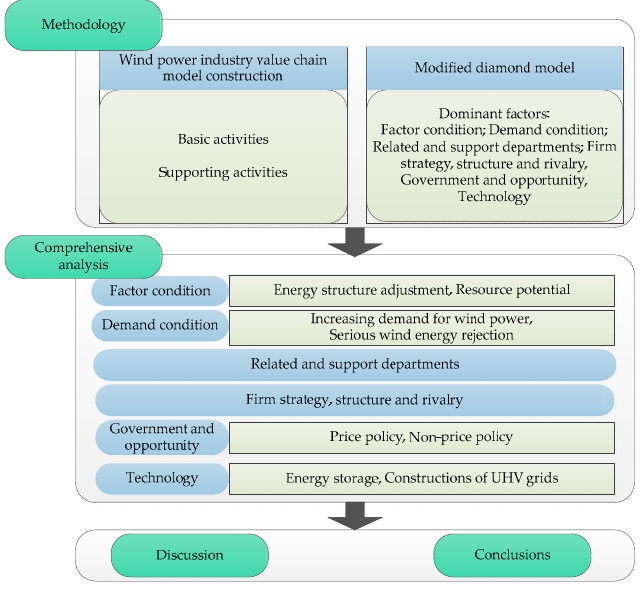
Figure 2. Schematic overview of the paper. Table 1. Main previous works focused on wind power industry analysis.